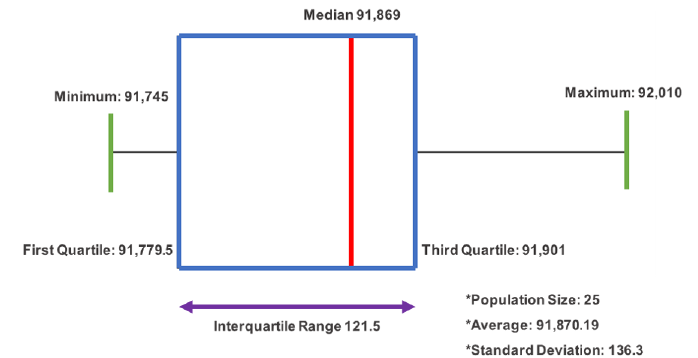
Figure 8. Transmission speed testing box and whisker plot